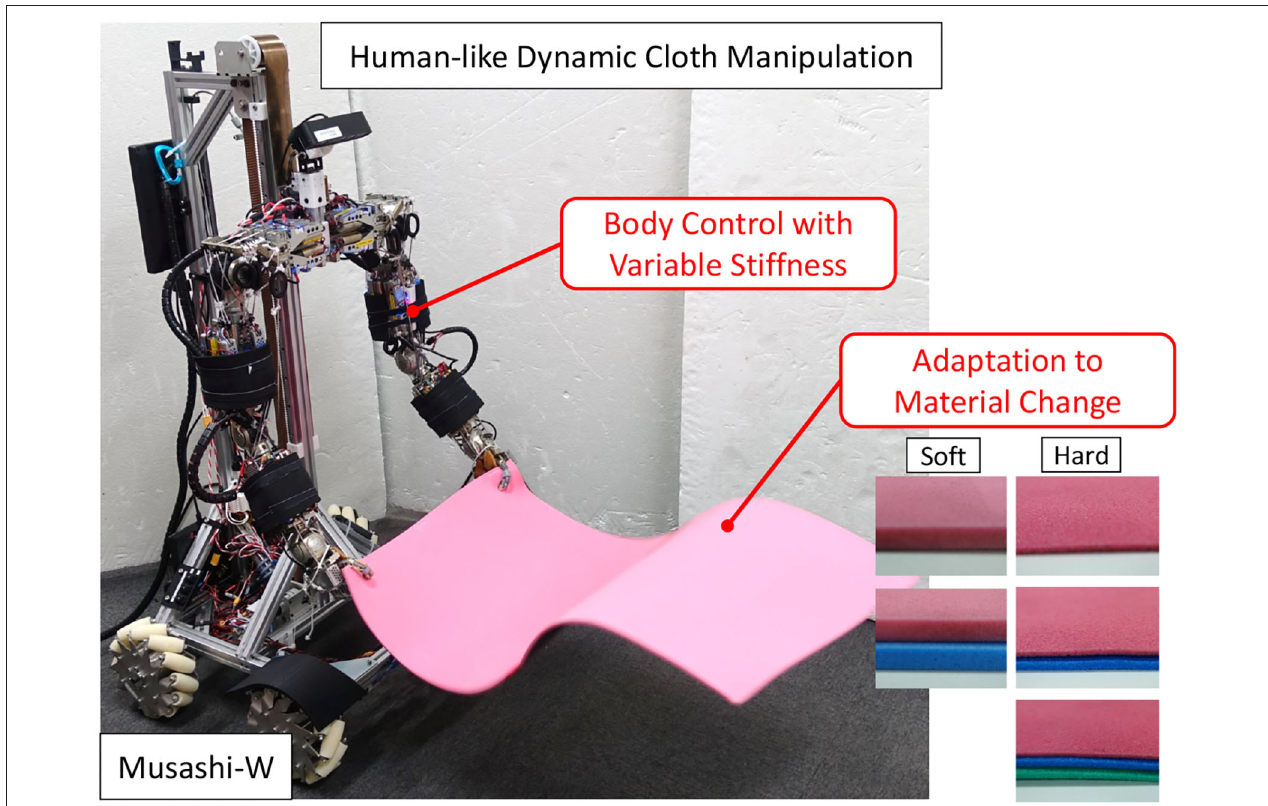
FIGURE 1 | Dynamic cloth manipulation by the musculoskeletal humanoid Musashi-W considering body control with variable stiffness and adaptation to material